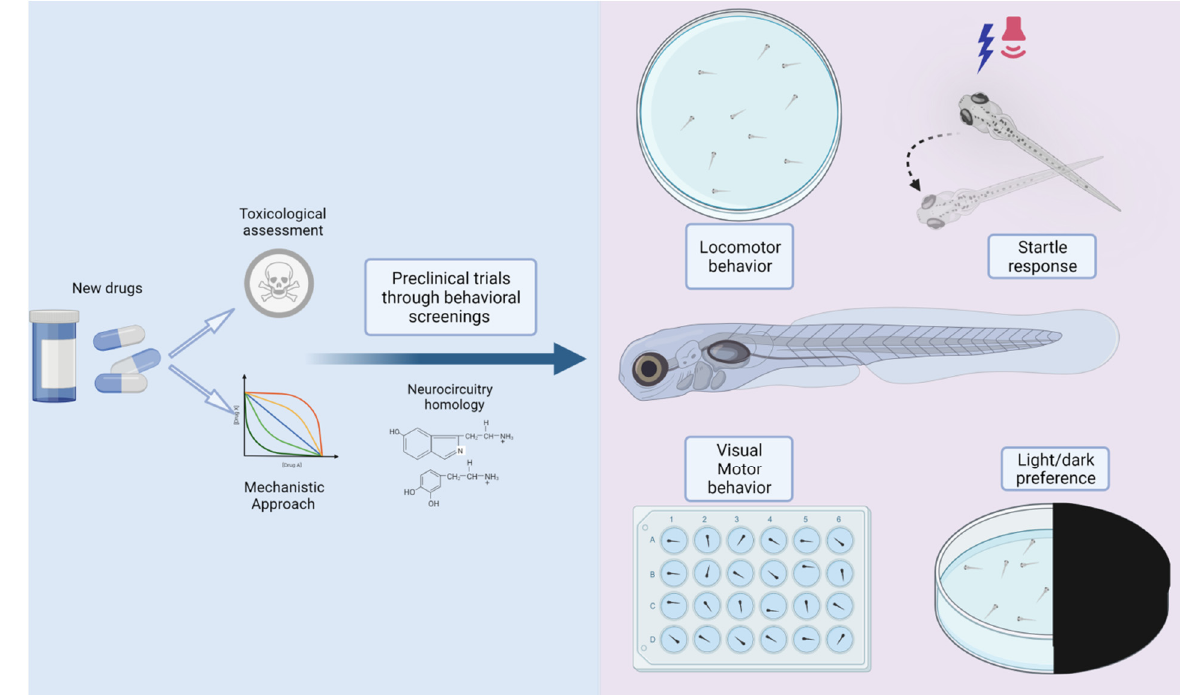
Figure 2. Behavioral response in zebrafish larvae. Changes in movement and locomotion profile, driven by complex neural circuits that include perception, cognition and decision-make processes, and visuomotor functions, can be used for the screening and discovery of candidate neurological drugs in the pre-clinical stage of development.